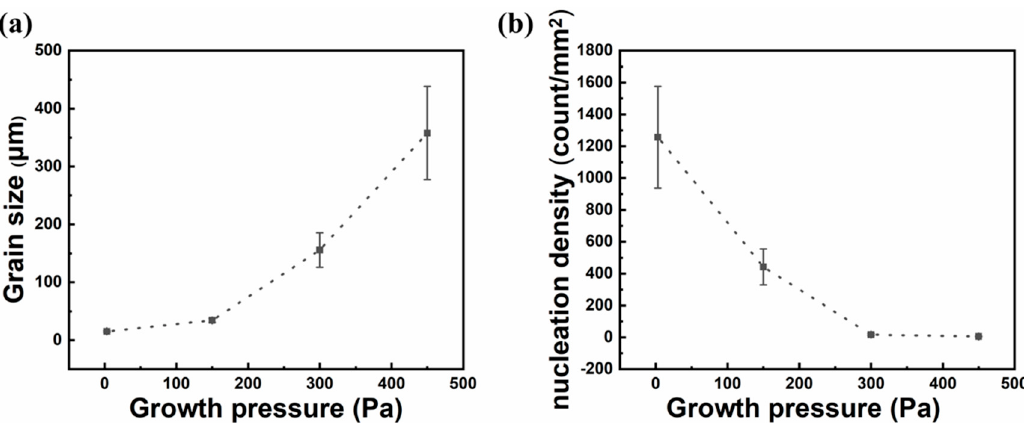
Figure 2. Nucleation density of graphene and size of single-crystal graphene at 3, 150, 300, and 450 Pa. ( a ) Relationship between growth pressure and size of single-crystal graphene. ( b ) Relationship between growth pressure and nucleation density of graphene.